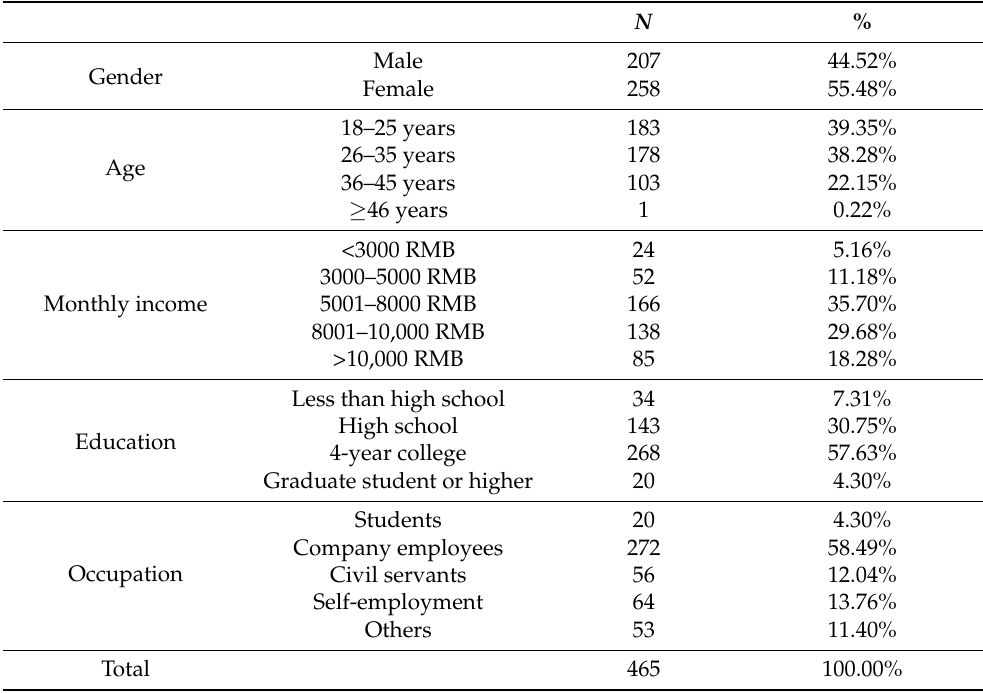
Table 1. General characteristics of the